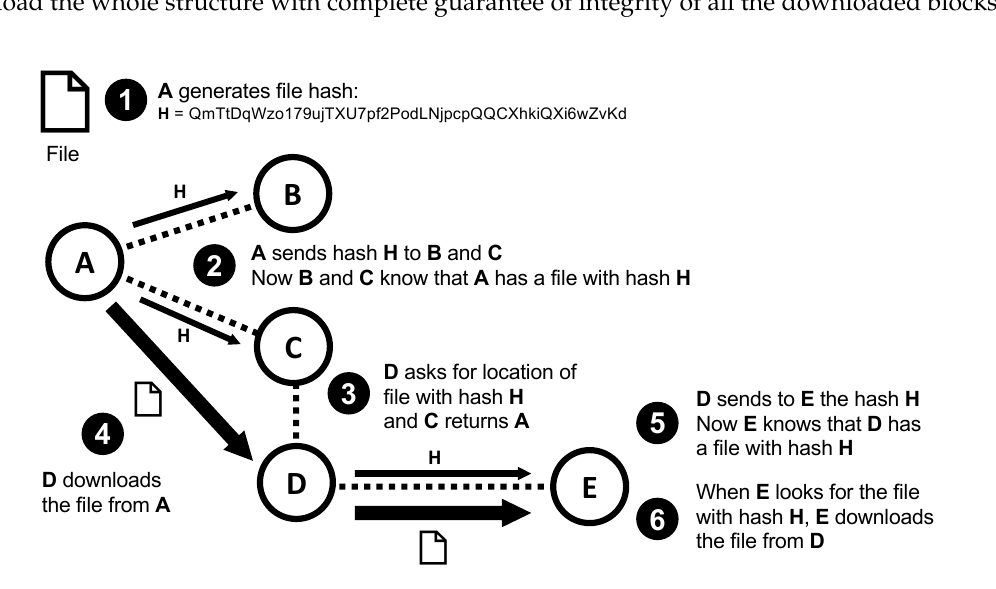
Figure 4. The peer A is the creator of the file. After sharing the hash, D can download the file from A. Immediately, D notifies E that it can download the file from it without connecting to